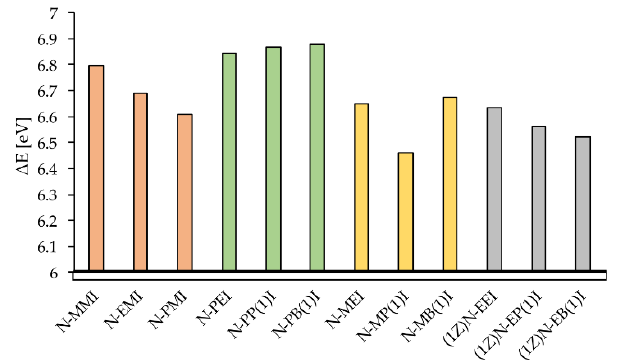
Figure 5. ΔE values of investigated aliphatic Schiff bases in aqueous phase . Figure 5. ∆ E values of investigated aliphatic Schiff bases in aqueous